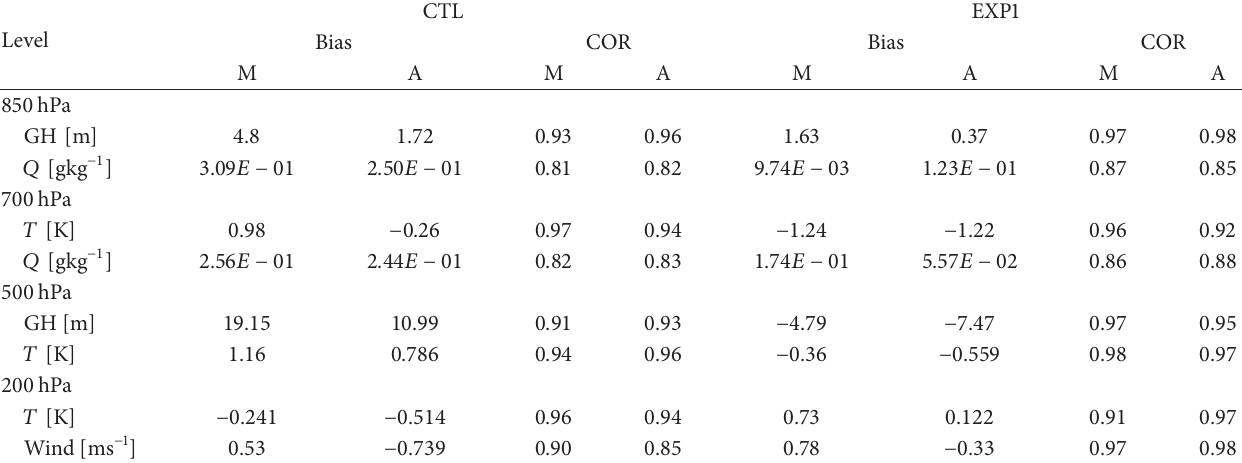
Table 2: March (M) and April (A) mean statistics of CTL and EXP1 compared with ECMWF reanalysis.